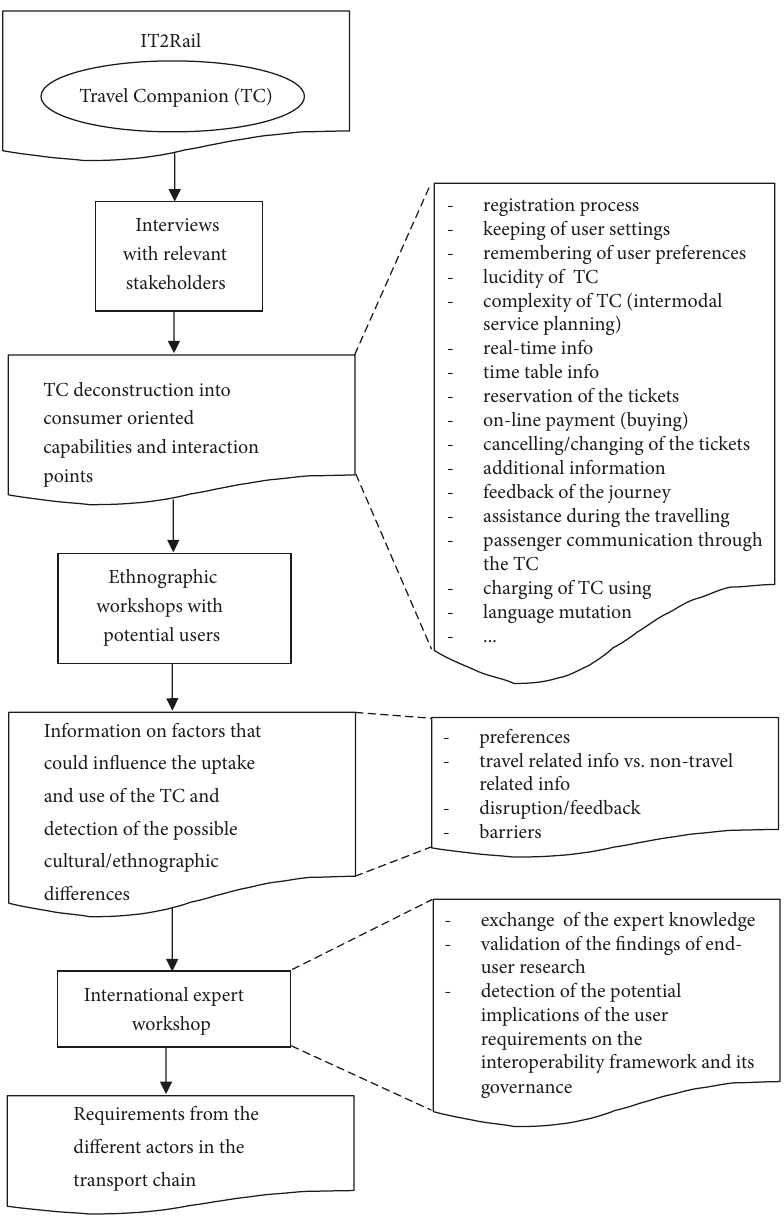
Figure 4: Partial topics of